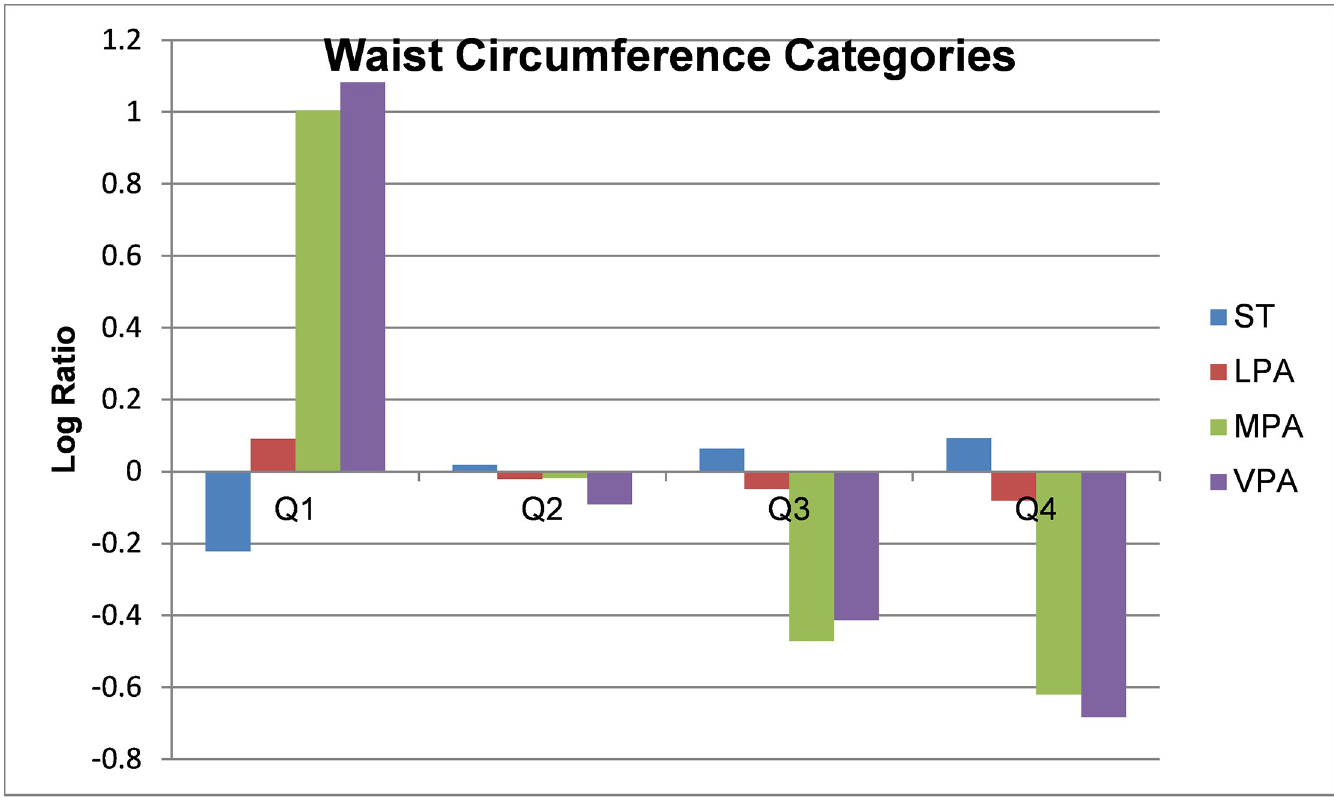
Fig 2. Compositional geometric mean bar plots the compositional mean of the entire sample with the compositional mean of waist circumference quartiles subgroups for sedentary time (ST), light-intensity physical activity (LPA), moderate-intensity physical activity (MPA), and vigorous-intensity physical activity